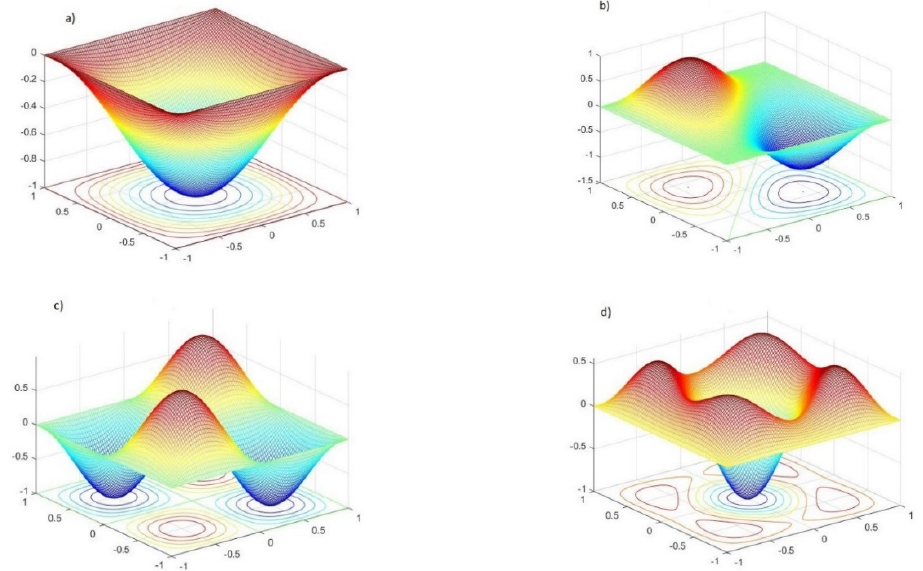
Figure 8. Vibrational modes for UD distribution without the agglomeration e ff ect: ( a ) 1st mode, ( b ) 2nd mode, ( c ) 4th mode, ( d ) 5th